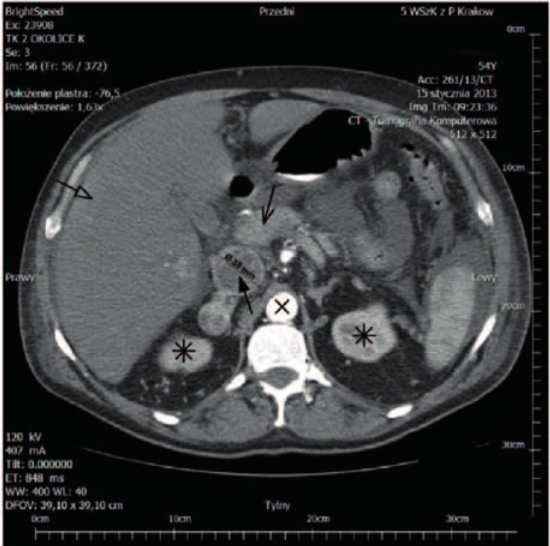
Figure 1. CT scan of abdomen done during fi rst hospitalization. It shows widened (diameter 38 mm), partially occluded inferior vena cava with masses that suggested thrombo- siss (marked by ). Surrounded organs are marked as followed: liver , aorta